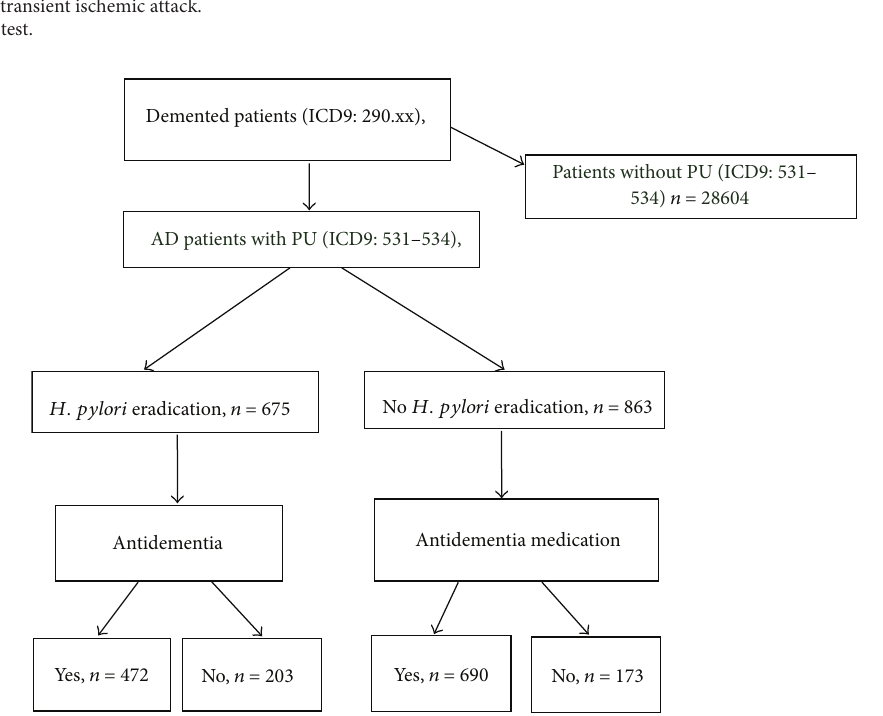
Figure 1: Flow chart of the study cohort assembly from prescriptions in Taiwan’s National Health Insurance Research Database. Taiwan National Health Insurance Database, 1 million subtract from 23